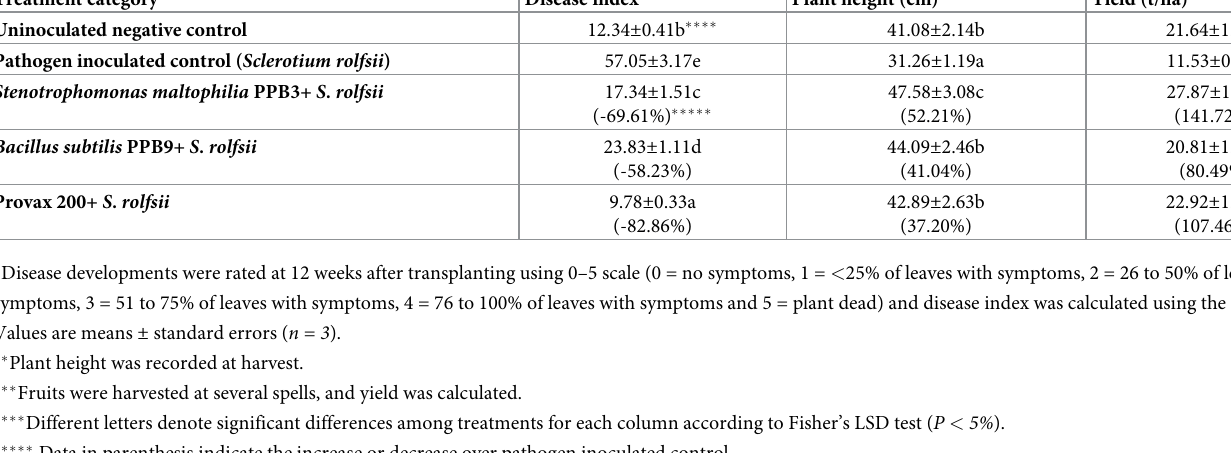
maltophilia PPB3 reached 240 × 10 7 and 165 × 10 7 CFU/g roots fresh weight, respectively, after seven weeks [Fig 5]. For both bacteria, root population densities were significantly higher in the bottom part than in the middle and upper part. The population differences among the three root segments increased with plant age and total bacterial population. At seven weeks, the root population of PPB9 in the bottom root parts was two and four folds higher than in the middle and upper root parts, respectively (S8 Table in S1 File). Similarly, the bottom root parts had two and three folds higher PPB3 populations at the same growth stage than the middle and upper root parts, respectively.